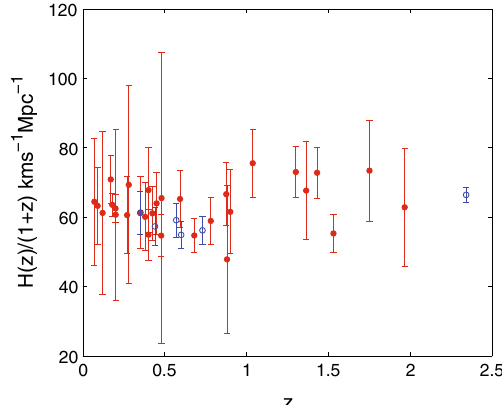
Fig. 1 Observed H ( z ) data from DA (red dot) and BAO (blue circle) with corresponding uncertainties